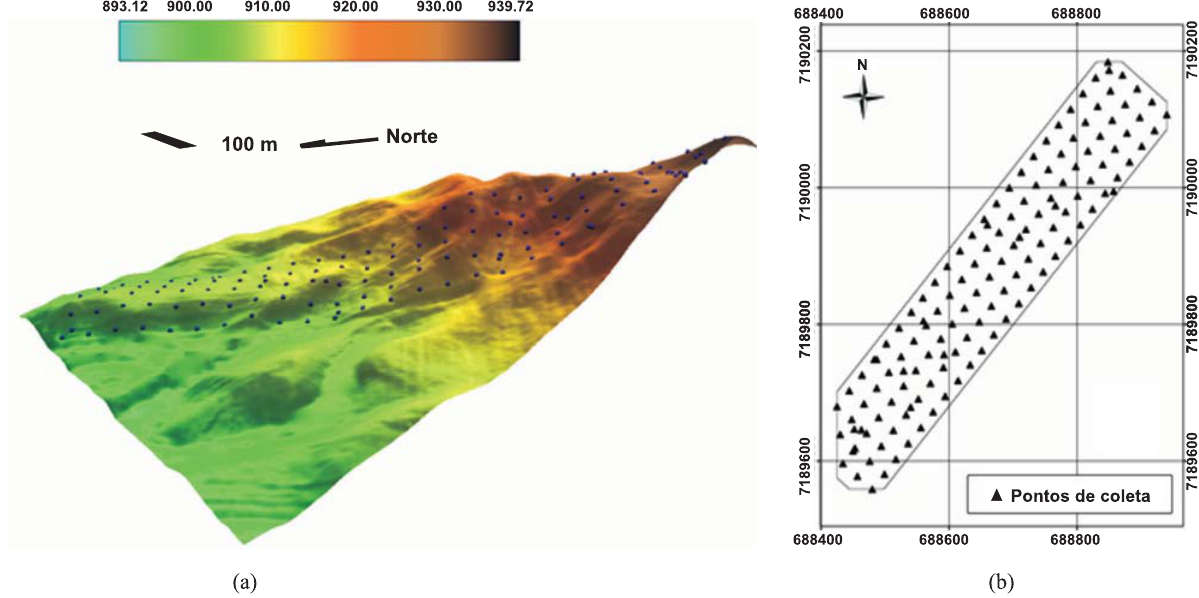
Figura 1. Relevo em 3D da área de estudo, situada na Fazenda Experimental do Canguiri (a) e distribuição dos pontos de amostragem em malha regular e mais 10 % de pontos com posicionamento aleatório dentro da malha regular